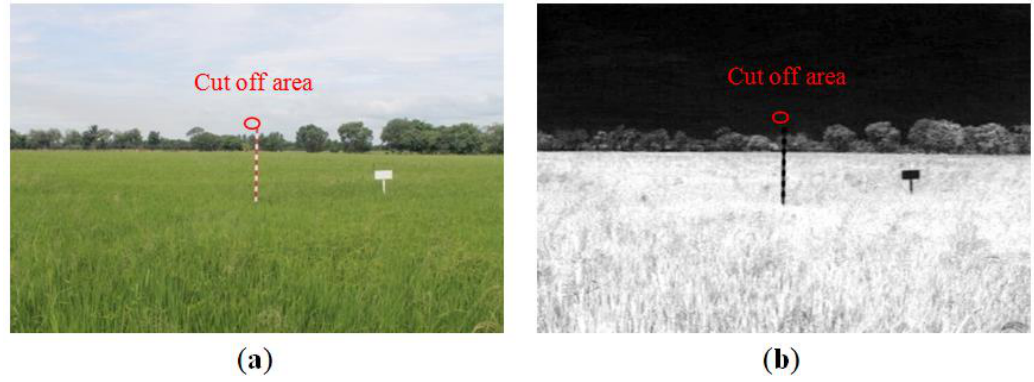
Figure 15. Cut off area (red circle) in ( a ) RGB and ( b ) modified filtered excess green